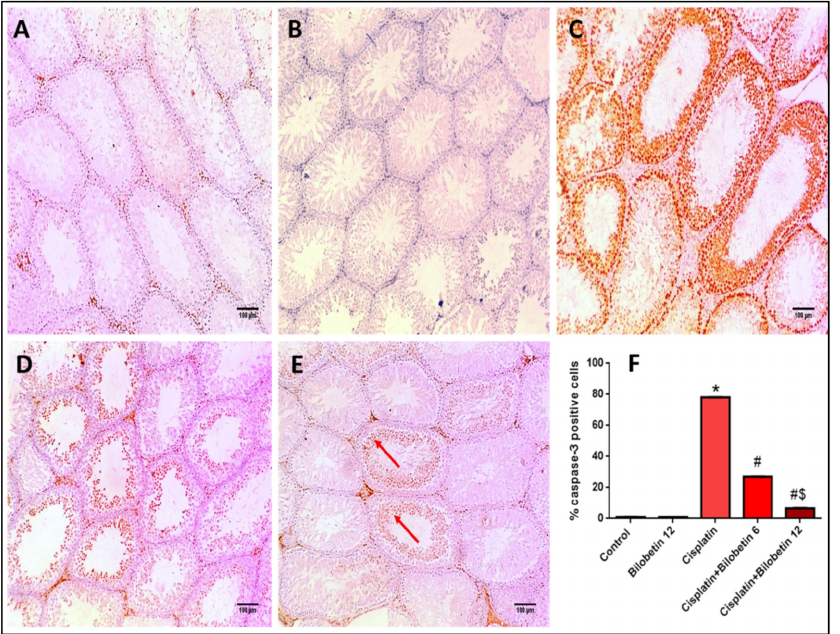
Figure 5. Effects of Bilobetin treatment on immunohistochemical staining of caspase-3. ( A ) Section of testis of normal control rat showed negative caspase-3 of spermatogenic cells ( × 100). ( B ) Section of testis of Bilobetin 12-only treated group showed negative caspase-3 staining of spermatogenic cells ( × 100). ( C ) Section of testis of CP treated rat (positive control) showed strong caspase-3 staining (more than 50%) of spermatogenic cells ( × 100). ( D ) Section of testis of CP+ Bilobetin 6 treated group showed moderate caspase-3 staining (red arrows) (less than 10%) of spermatogenic cells ( × 100). ( E ) Section of testis of CP+ Bilobetin 12 treated group showed mild caspase-3 staining (10–50%) of spermatogenic cells (red arrows) ( × 100). ( F ) Percent of caspase-3 positive cells/1000 cells per 10 high power fields. Data expressed as mean ± SD ( n = 8/group). Significant difference vs. * respective control; # respective CP group; $ respective CP+ Bilobetin 6 group each at p <